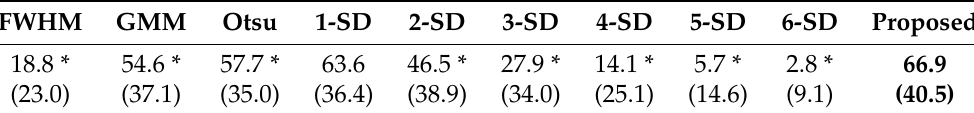
Table 6. Mean (standard-deviation) sensitivity for detecting microvascular obstruction areas per method.